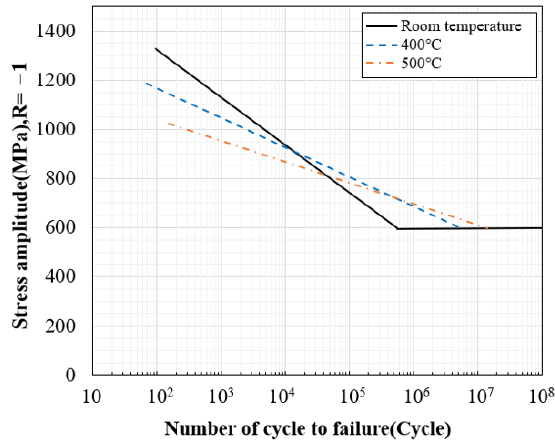
Figure 18. The S–N curve comparison graph of Figure 18. T he S–N curve comparison graph of SKD61.